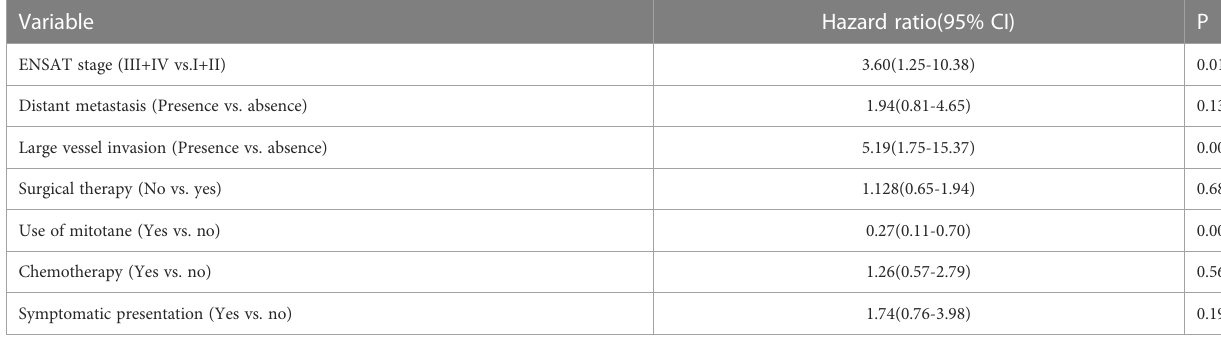
TABLE 3 Multivariate Cox regression analysis on overall